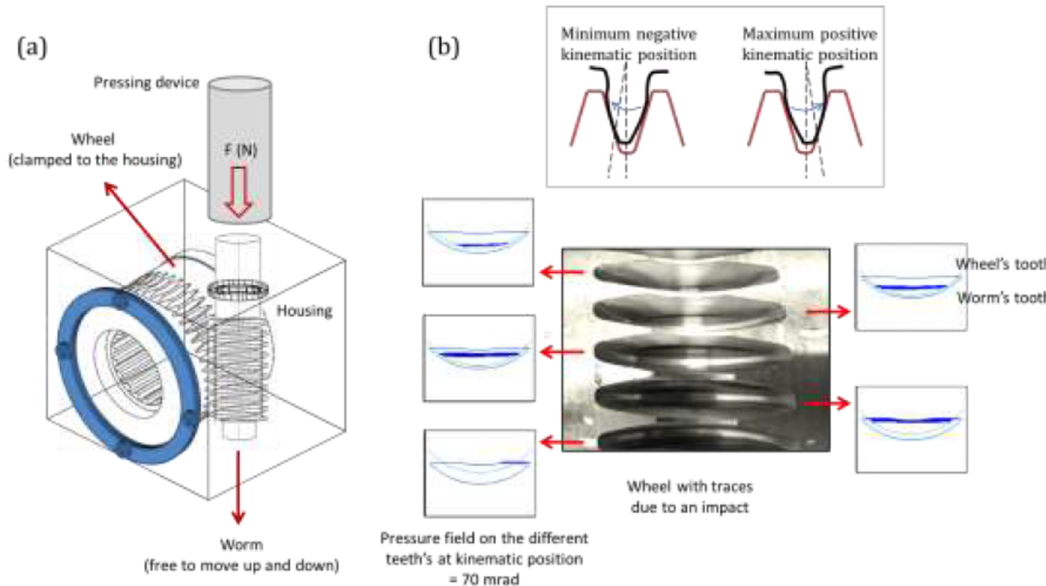
Fig. 10. (a) Pressing device; (b); Determination of the kinematic position by comparison between the traces after impact on the wheel and the pressure fi eld as calculated by ROUVISLAM.